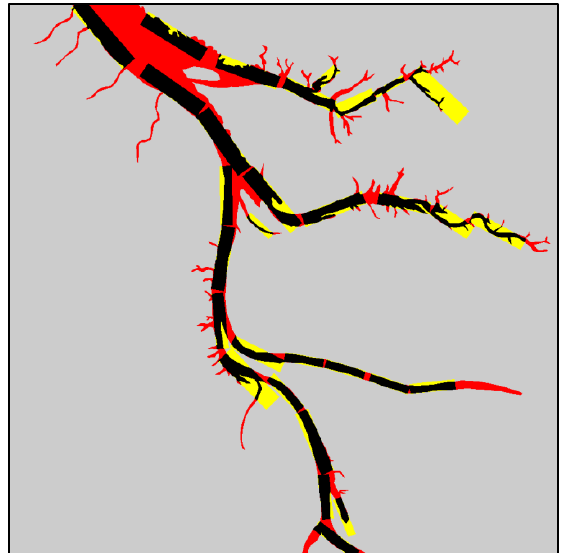
Figure 7. Results for area 1 with the parameter c i = 200 m² and l i max = 1/5 (top) and for c i = 200 m² and l i max = 1/2 (bottom) (black = TP, yellow = FP, red = FN, gray = TN).